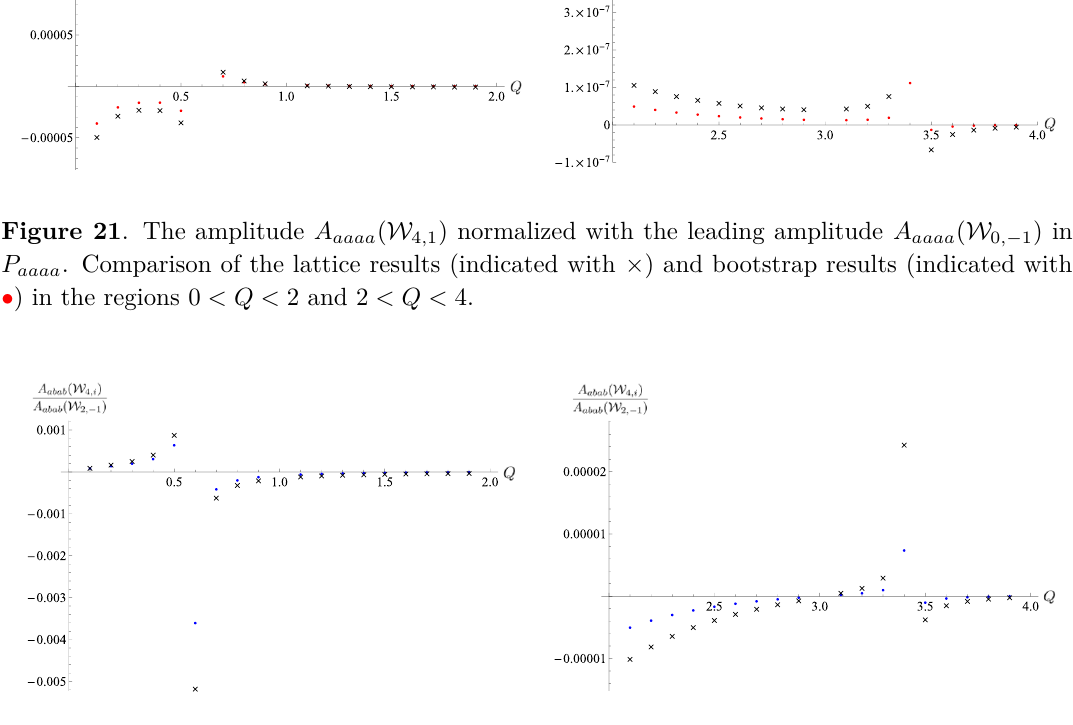
Figure 22 . The amplitude A abab ( W 4 ,i ) normalized with the leading amplitude A abab ( W 2 , − 1 ) in P abab − P abba . Comparison of the lattice results (indicated with × ) and bootstrap results (indicated with • ) in the regions 0 < Q < 2 and 2 < Q < 4